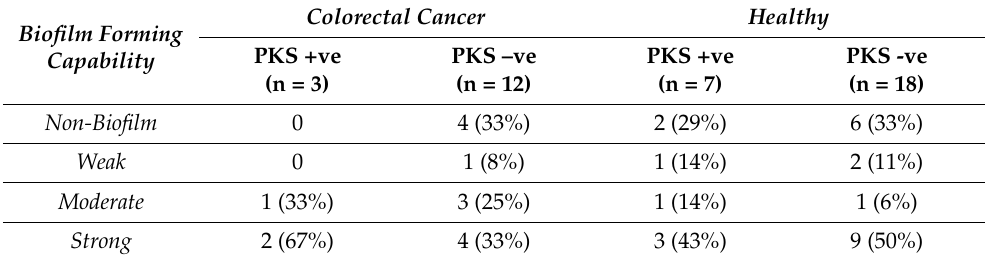
Table 6. Biofilm forming capabilities among K. pneumoniae isolates.